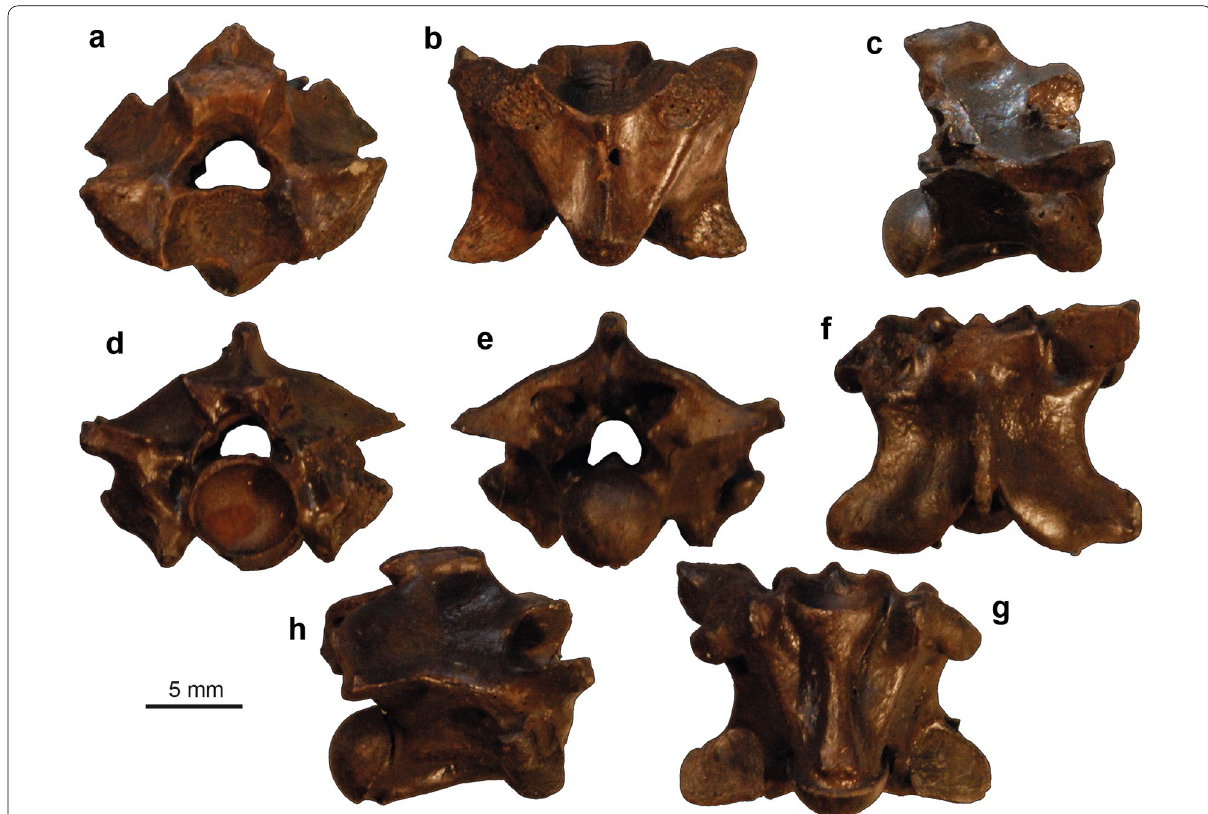
Fig. 55 Eoconstrictor cf. fischeri from quarry I, Geiseltal: a , b mid-trunk vertebra (GMH I-10111a-1949) in anterior ( a ) and ventral ( b ) views; ( c ) posterior trunk vertebra (GMH I-10111d-1949) in right lateral view; d – h ?posterior-most trunk vertebra (GMH I-10111c-1949) in anterior ( d ), posterior ( e ), dorsal ( f ), ventral ( g ), and right lateral ( h )